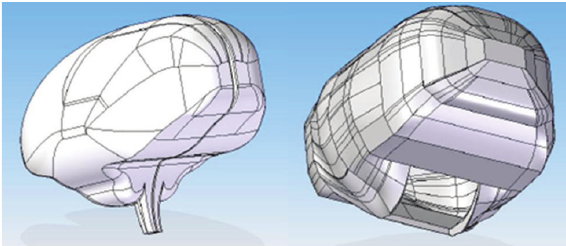
Figure 5: Views of the brain and skull